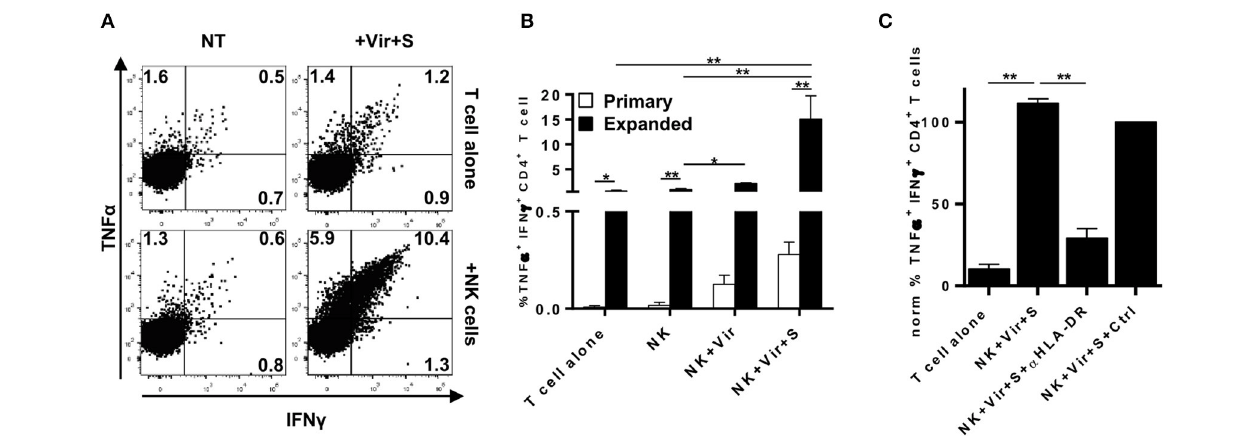
FIGURE 6 | Antigen presentation by expanded HLA-DR + NKG2C + NK cells to HCMV-specific autologous CD4 + T cell lines. Expanded NKG2C + NK cells pre-loaded with HCMV in the presence of immune serum were cultured overnight with HCMV-expanded CD4 + T cells. Intracellular TNF α and IFN γ was analyzed by flow cytometry. (A) TNF α and IFN γ in CD4 + T cells cultured in the indicated conditions. Data from a representative donor. (B) Comparison of the frequency of TNF α + IFN γ + CD4 + T cells in co-culture experiments using primary or expanded antigen presenting and effector cells (mean ± SEM, n = 5) (* p < 0.05, ** p < 0.01). (C) Frequency of TNF α + IFN γ + HCMV-expanded CD4 + T cells upon co-culture with antigen-loaded NK cells in the presence of an α -HLA-DR (clone D1.12) or an isotype control (mean ± SEM, n =